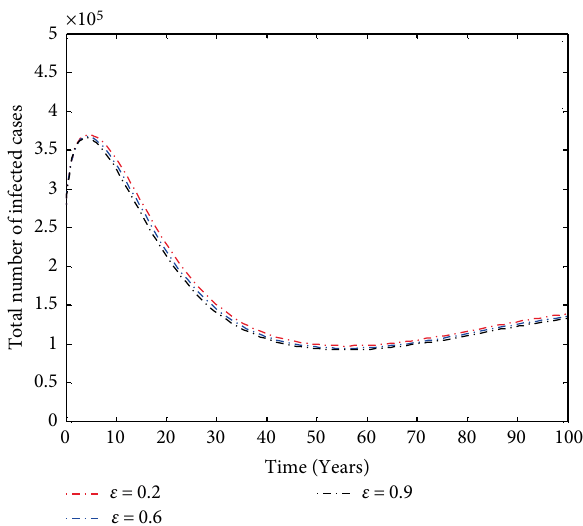
Figure 5: The effect of vaccination coverage on the number of infected class.